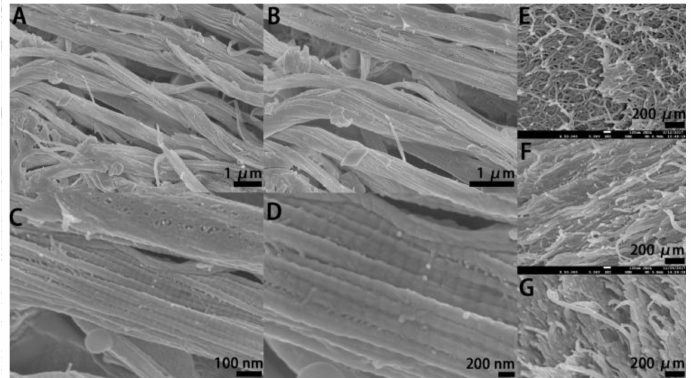
Figure 2. Representative SEM micrographs of the electrocompacted collagen matrices (ECL) before crosslinking at various magnifications ( A – D ), and crosslinked traditional collagen gel (( E ), GEL), crosslinked ECL (( F ), ECLC), crosslinked ECL incorporated with SXRGlu (( G ), ECLCU).